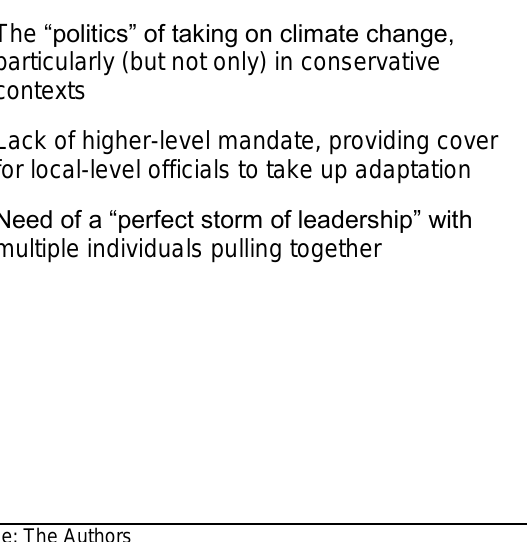
Table A2.3: Characteristics, Underlying Causes and Potential Solutions to